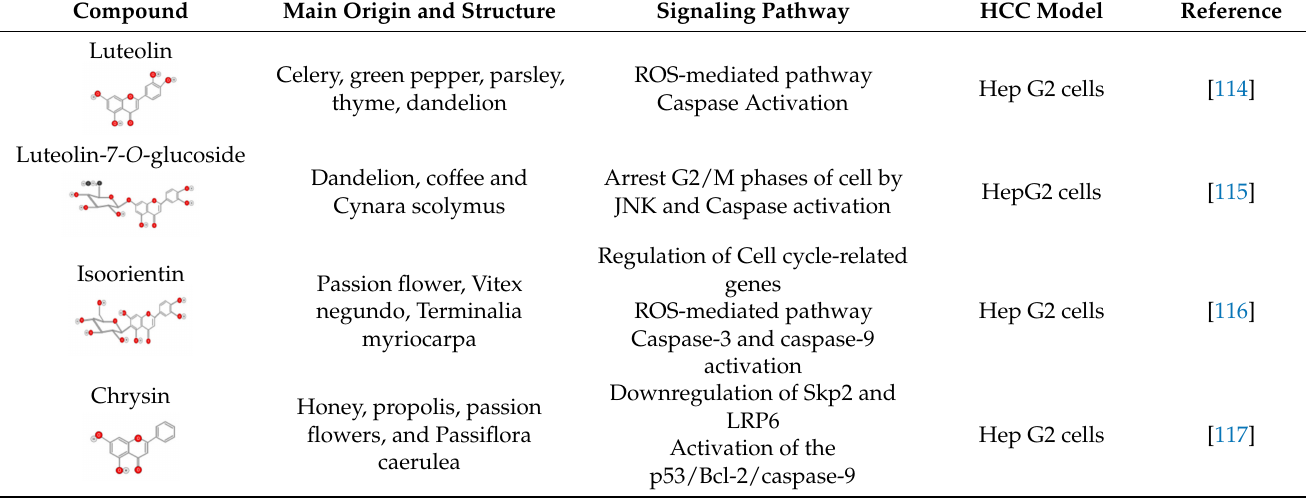
Table 2. Origins of flavonoids and their targeted signaling pathways that induce apoptosis and inhibit cell proliferation and angiogenesis. Main Origin and Structure Signaling Pathway HCC Model